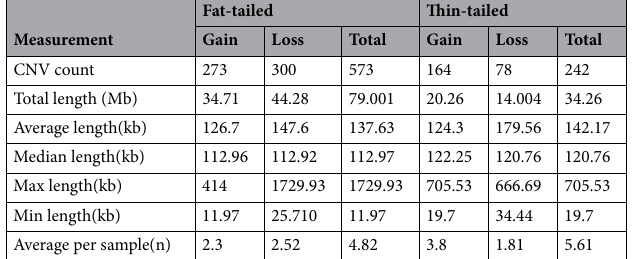
Table 2. Copy number variation characteristics in two tail type sheep